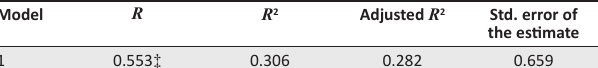
TABLE 4: Regression analysis: Risk factors. † Model